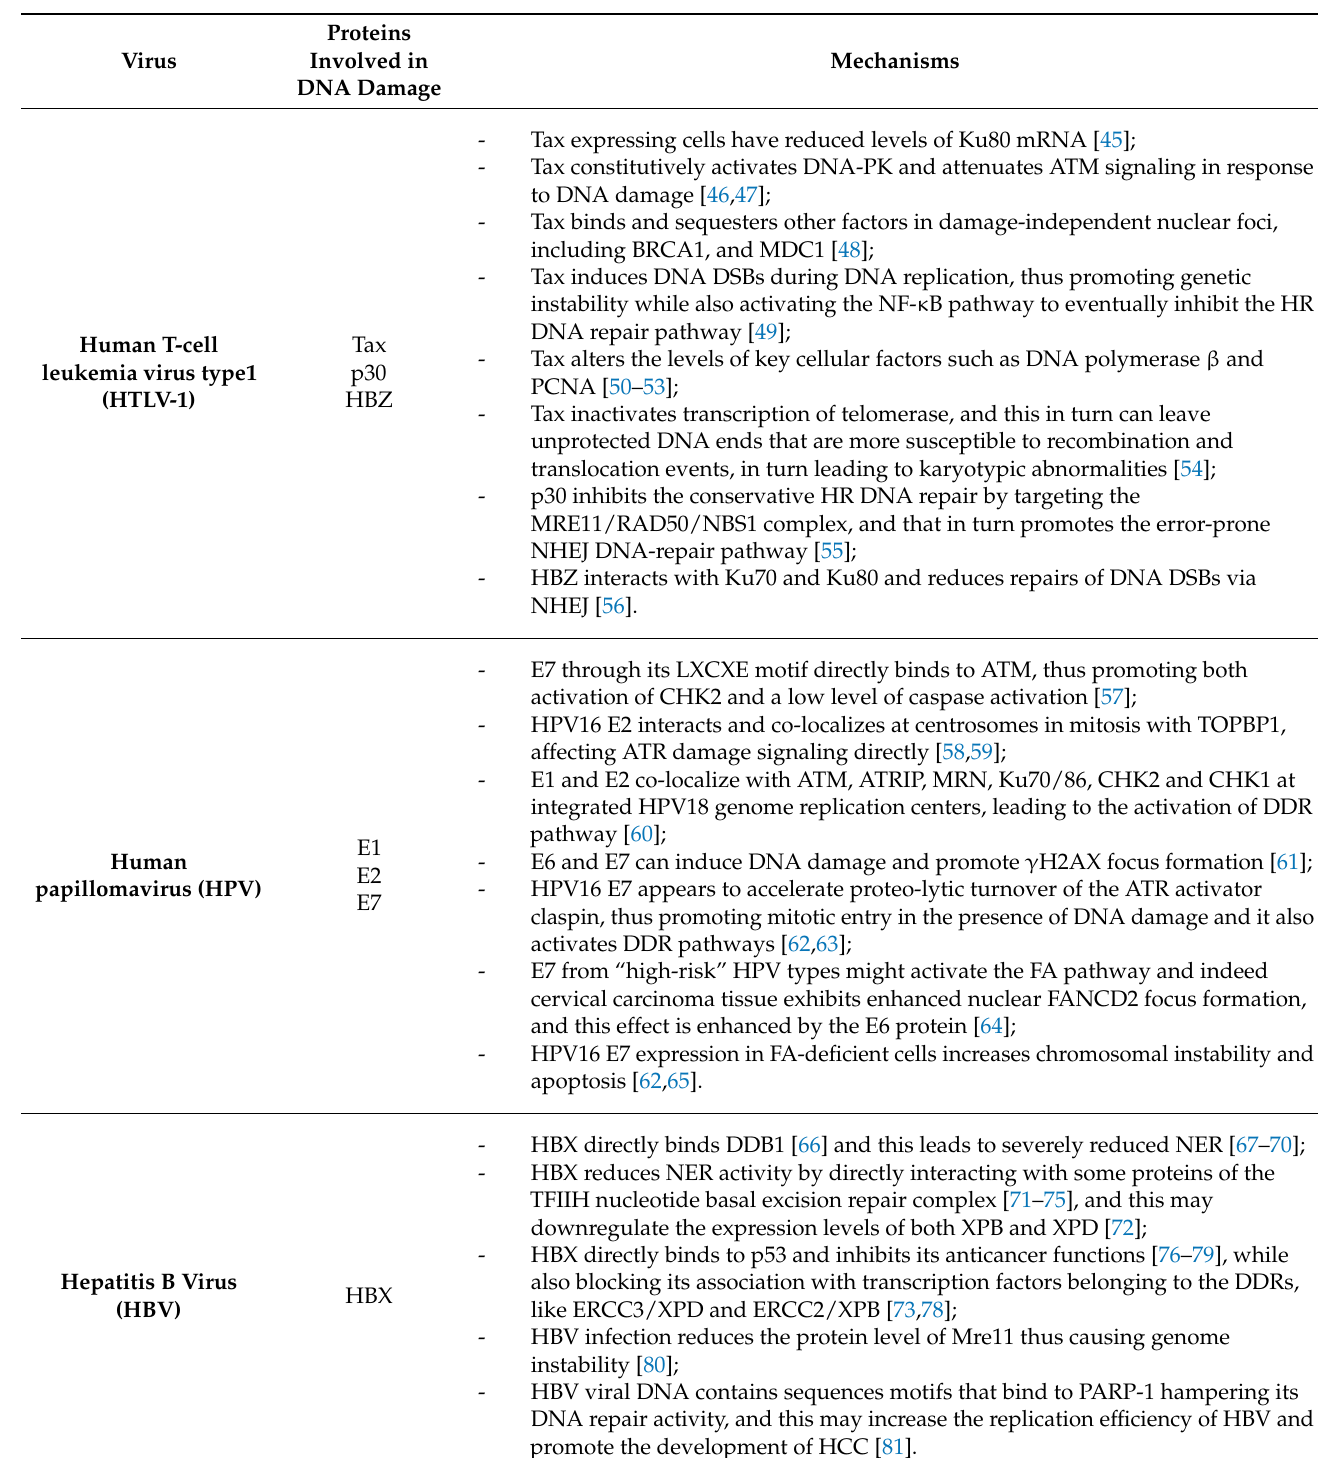
Table 1. Viruses and DNA